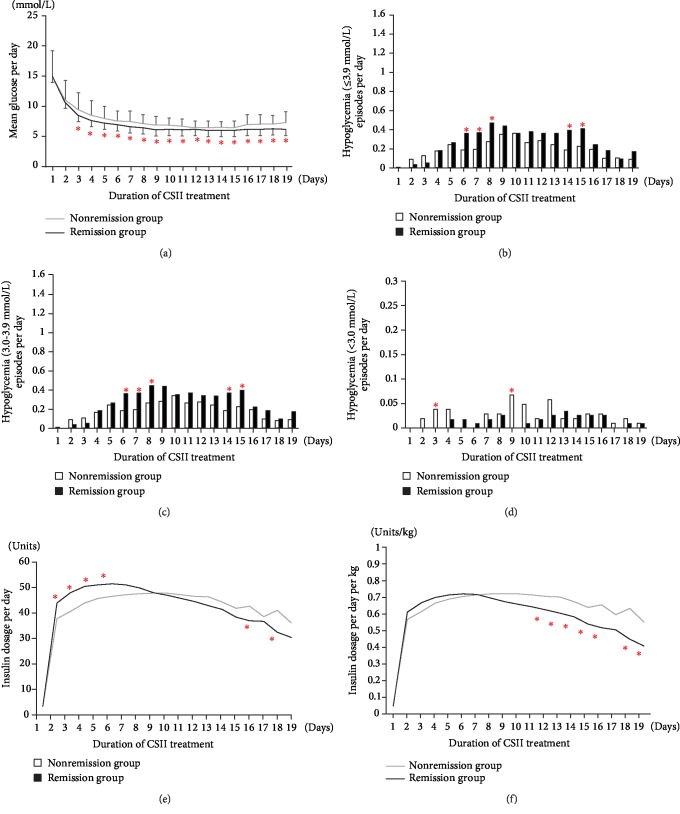
Glucose profiles (a), daily hypoglycemic episodes (b–d), and daily insulin doses (e, f) of patients during continuous subcutaneous insulin infusion (CSII) therapy in the remission group and the nonremission group. Compared with those in the nonremission group, patients in the remission group had a lower mean glucose, an increased mild hypoglycemia episode, a higher initial insulin dose, and a lower dose before removal of the insulin pump. Glucose profiles (a) and daily insulin doses (e, f) were compared by t-test. The number of hypoglycemic episodes (b–d) was calculated by rank-sum tests. ∗ means P < 0.05.